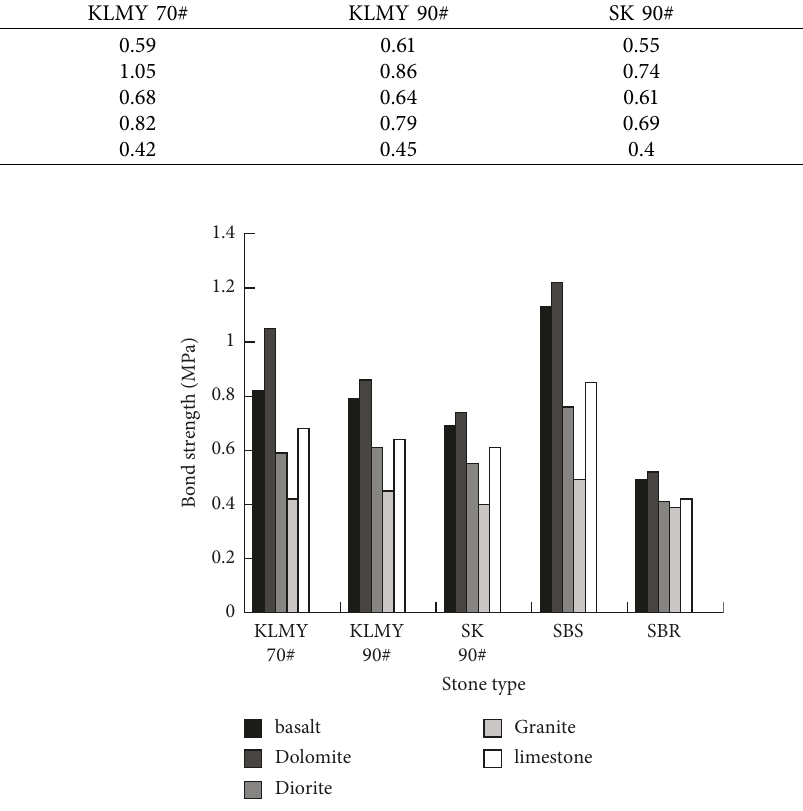
Figure 6: Comparison of bond strength between different asphalt and stone base Table 7: Two-factor ANOVA without replication.